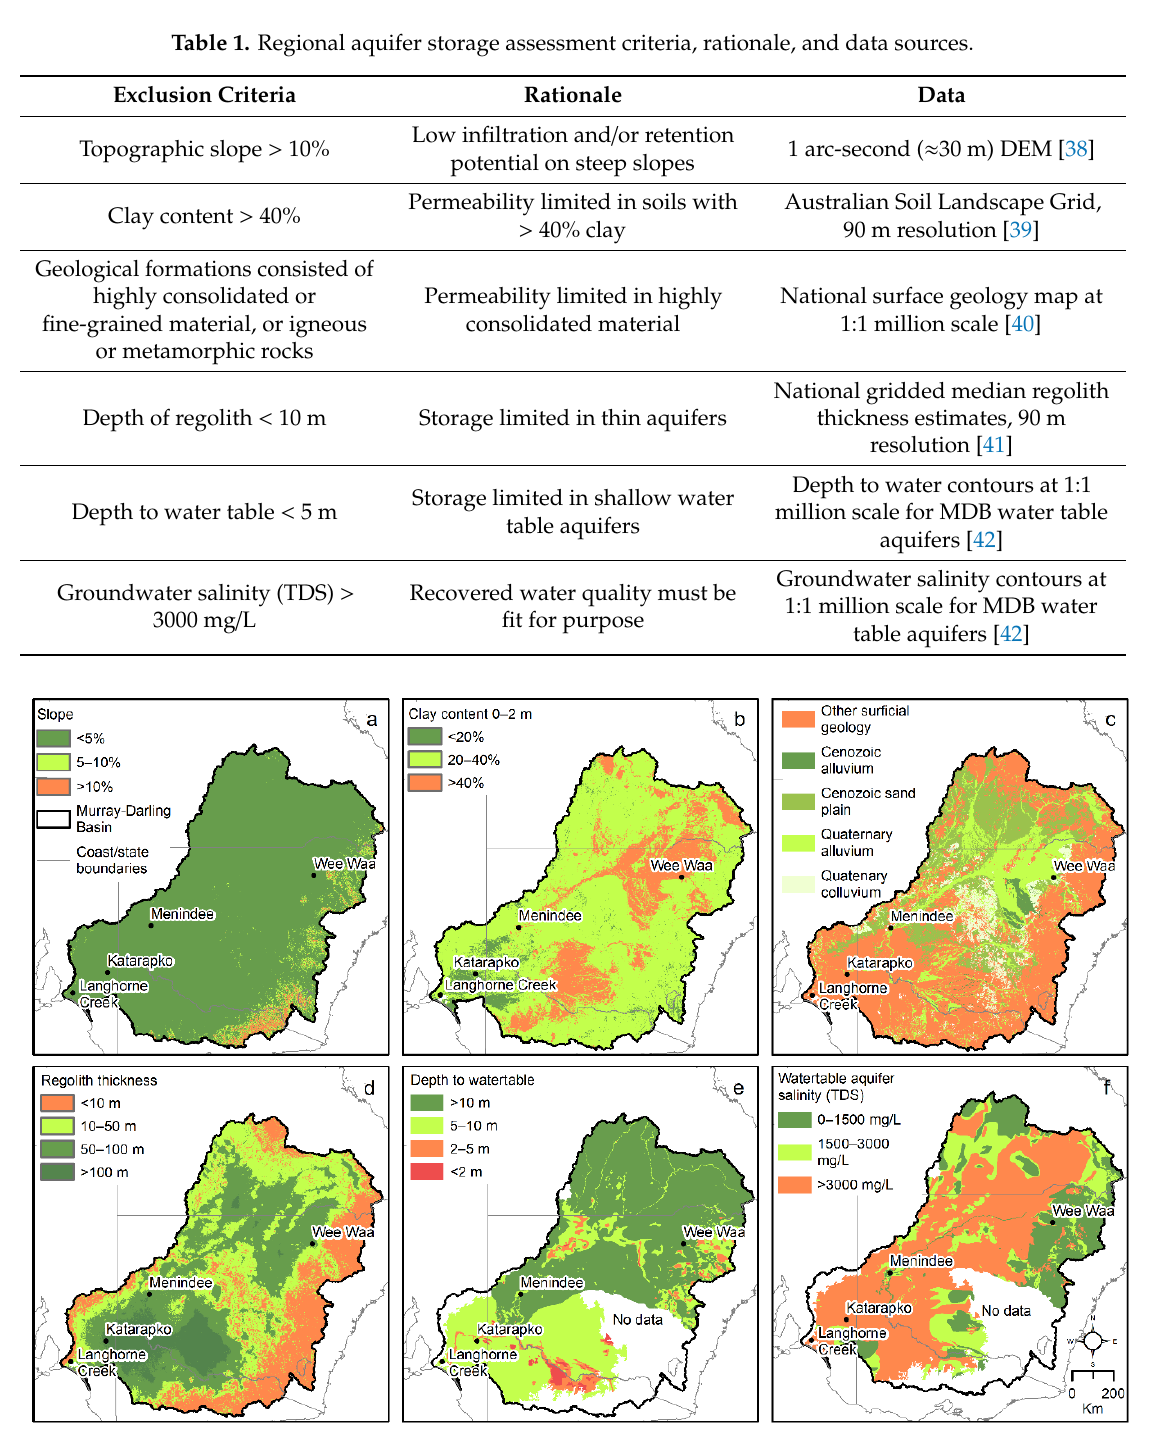
Figure 2. Spatial input parameters for assessment of aquifer storage potential in the Murray–Darling Basin: topographic slope ( a ), soil clay content ( b ), surficial geology ( c ), regolith thickness ( d ), depth to water table ( e ), groundwater salinity ( f ).